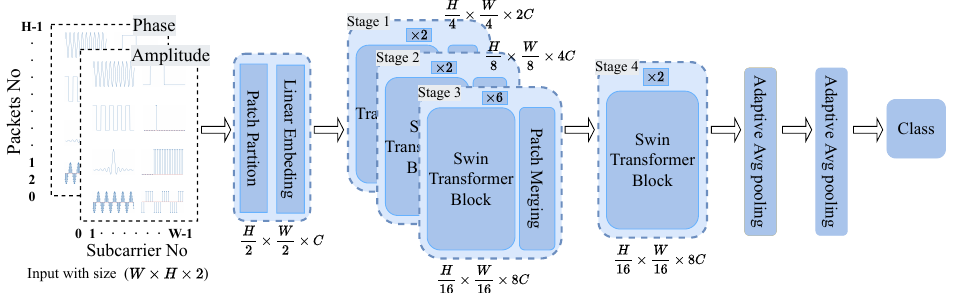
Figure 6. Architecture of Swin-Transformer-based authentication module